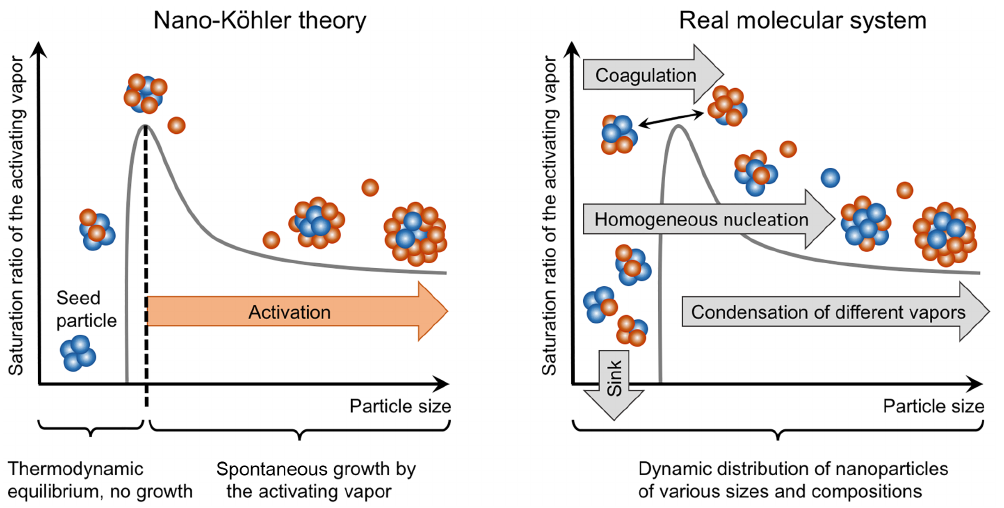
Figure 1. Schematic figure illustrating how the growth of atmospheric molecular clusters is described by nano-Köhler theory, and how the growth occurs in real molecular systems affected by various dynamic processes. Table 1. Comparison between Köhler theory, nano-Köhler theory and real systems of atmospheric molecular